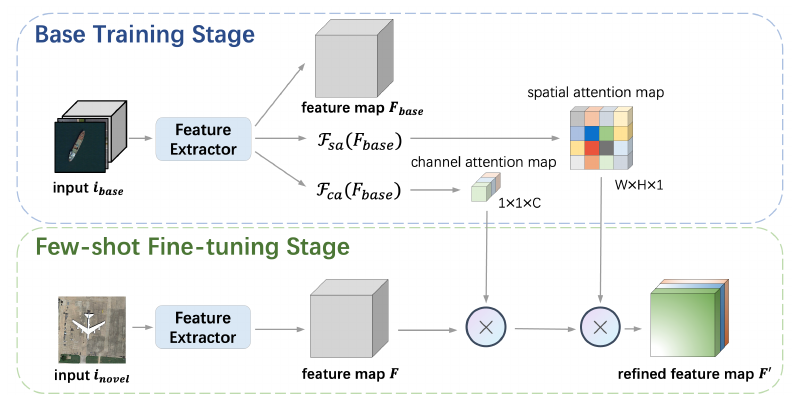
Figure 4. The architecture of our shared attention module